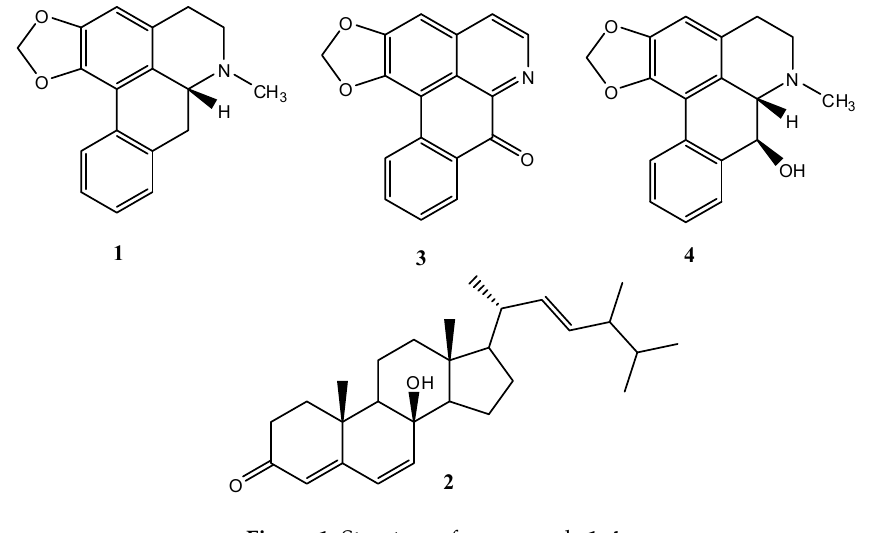
Figure 1. Structure of compounds 1 – 4 .